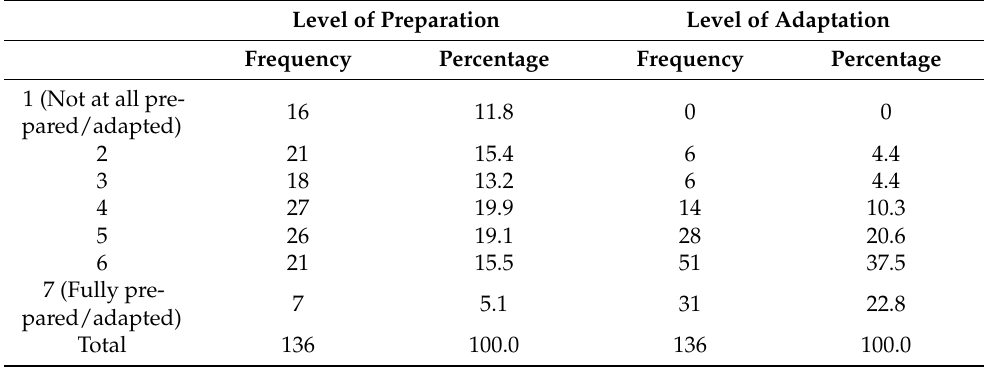
Table 2. Organizations’ level of preparation and adaptation for dealing with the COVID-19